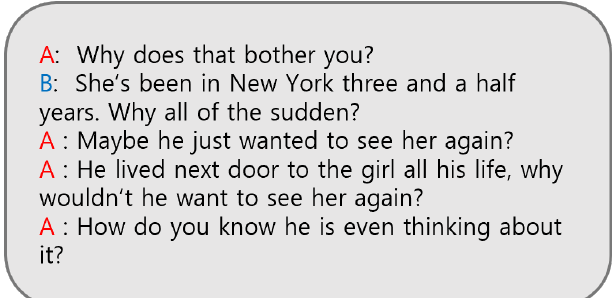
Figure 3. A one by one dyadic conversation.